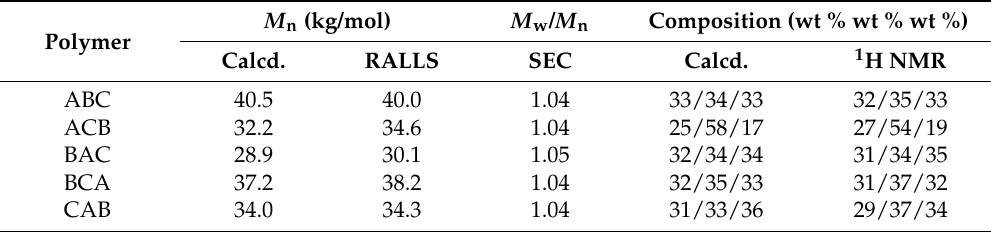
Table 10. Characterization results of ABC, ACB, BAC, BCA, and CAB triblock terpolymers.